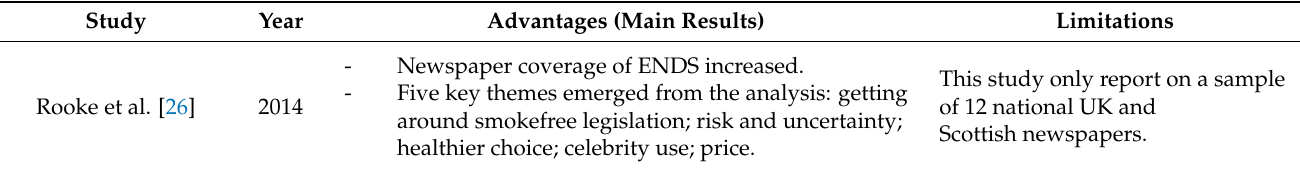
Table A2. Summary of studies analyzing e-cigarettes